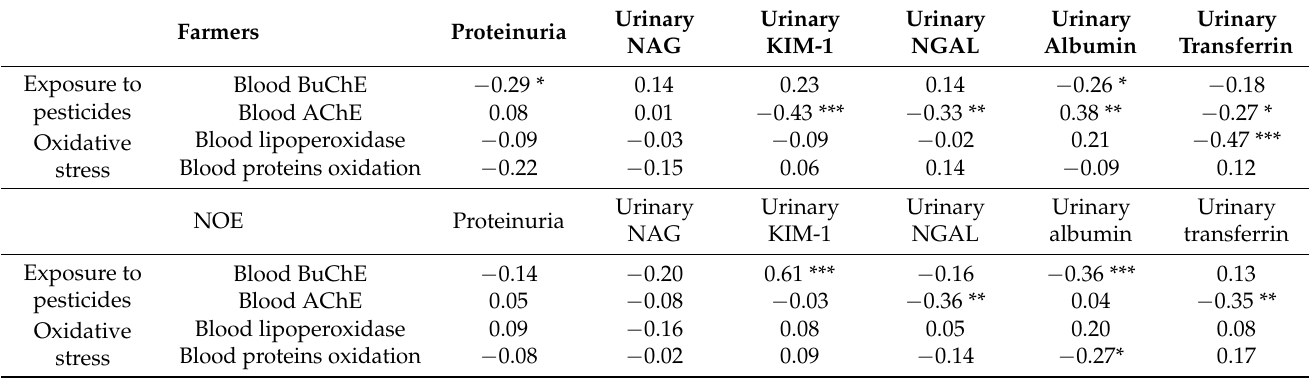
Table 5. Results of the correlation study carried out between the urinary biomarkers evaluated and blood parameters of exposure to pesticides. Data are expressed as Spearman’s correlation coefficient ( ρ ). Significance of the correlation: * p < 0.05; ** p < 0.01; *** p < 0.001. AChE: acetylcholinesterase; BuChE: butyrylcholinesterase; KIM-1: kidney injury molecule